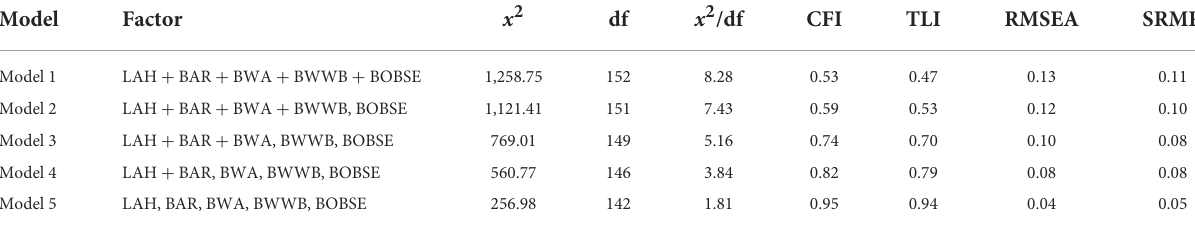
TABLE 1 Results of confirmatory factor analysis.